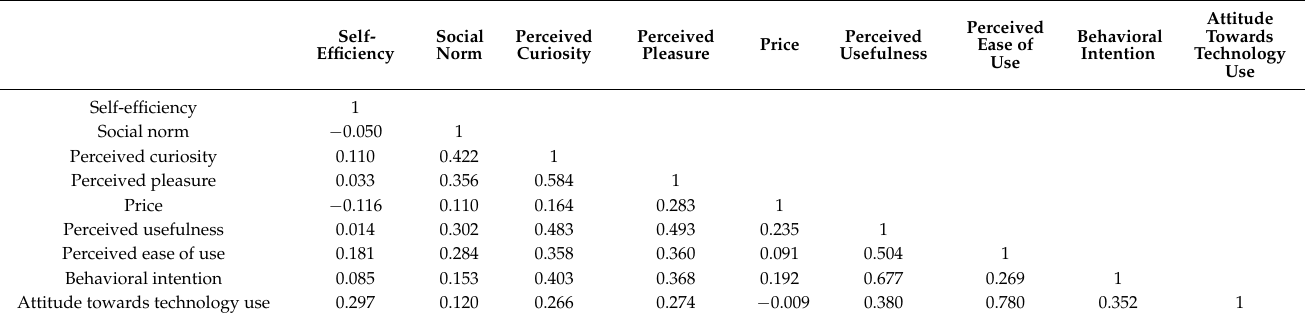
Table 2. Correlation between factors.